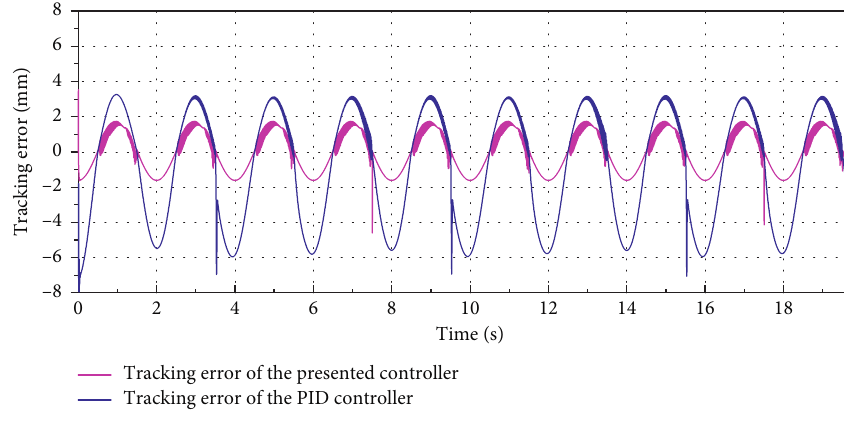
Figure 7: Tracking error in test